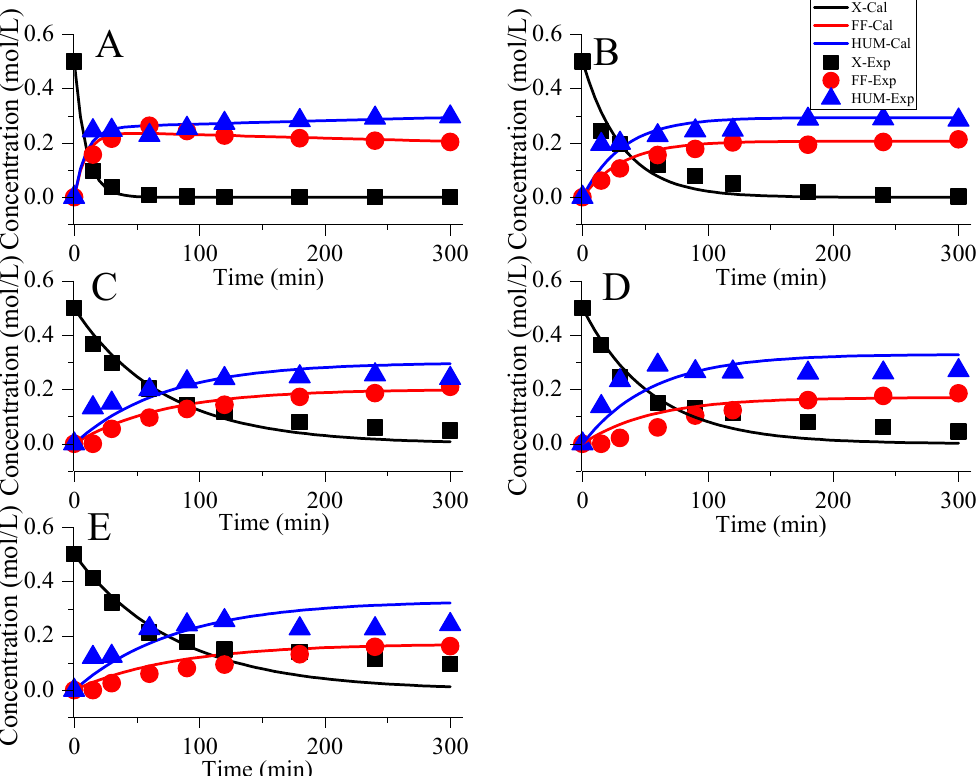
Table 4. Fitted reaction parameters for xylose conversion into furfural in DMSO. Reaction conditions: 0.5 M xylose, 1.0 M for 5 h.